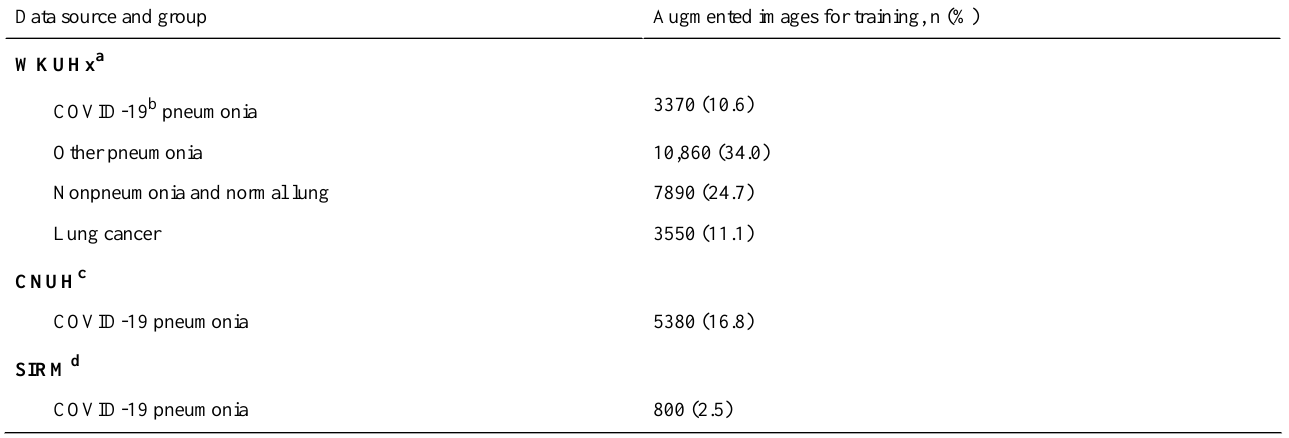
Table 3. Augmented images for training in each group (N=31,940).